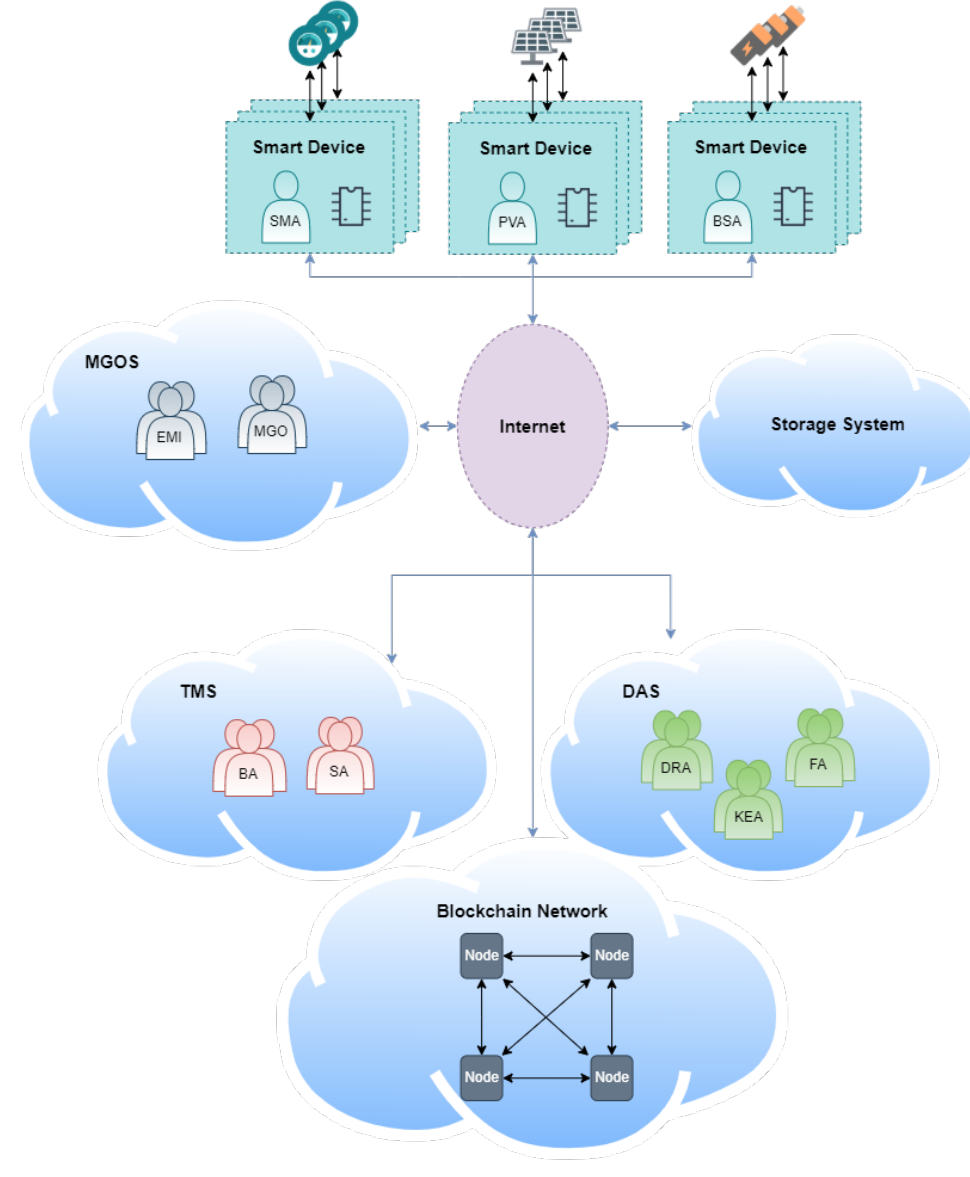
Figure 6. Platform deployment